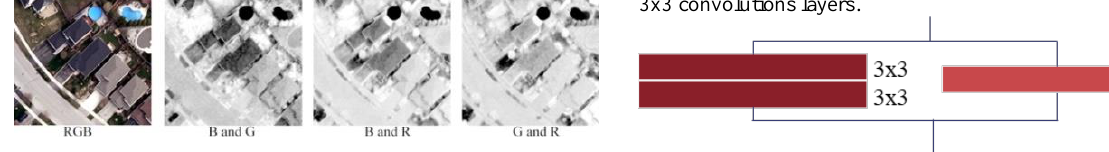
Figure 1 . Ratio results of different bands